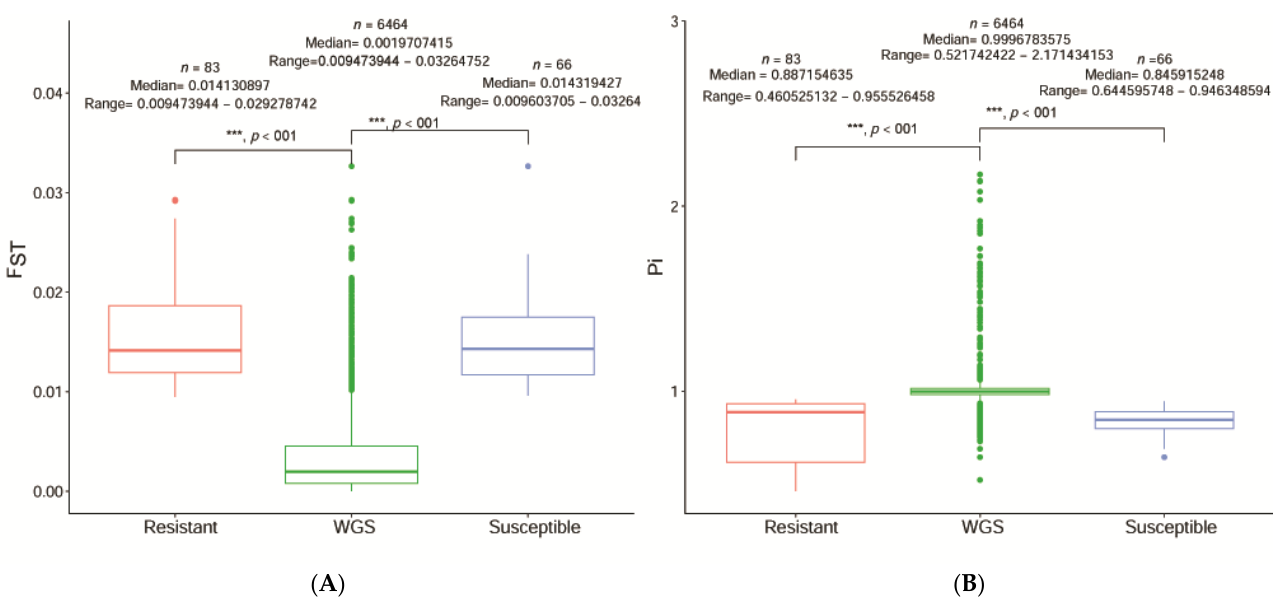
Figure 4. Distributions of selective sweep analysis results of significant regions of intersection F ST and π ratios between R and S in A. c. cerana larvae that had undergone positive selection the top 5% of the whole genome. ( A , B ) Comparison analysis of selected regions based on population differentiation index (F ST ) and nucleotide polymorphisms (π) of the significant intersecting regions (top 5%) of genome variants between R (resistant) larvae and S (susceptible) larvae of A. c. cerana. Data were reanalyzed and plotted from analyzed significance regions.